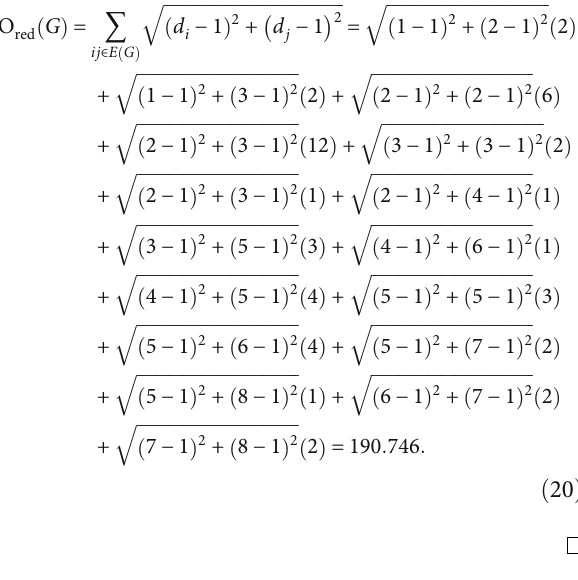
Table 3: Edge partitioning based on degree of hydroxychloroquine. E